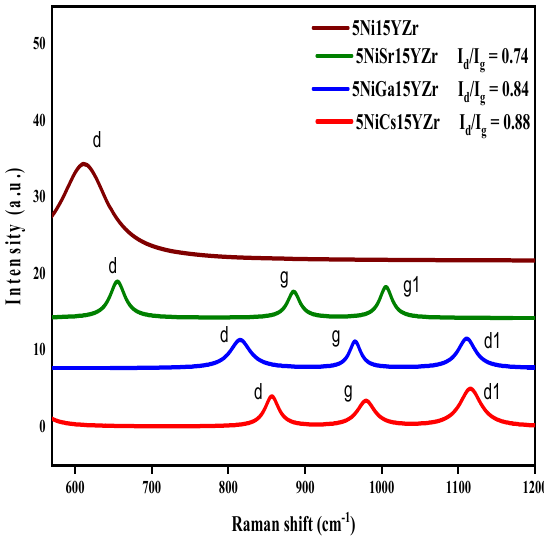
Figure 11. Raman spectra for the promoted spent catalysts.